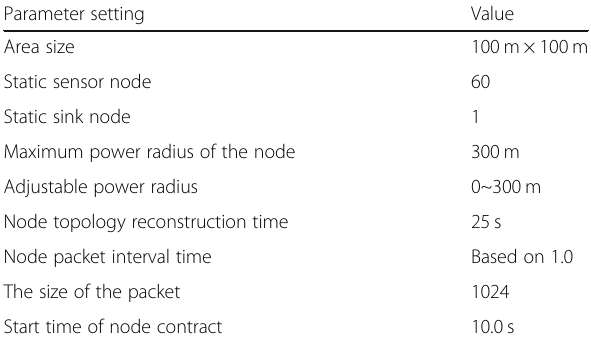
Table 1 Parameter setting of simulation experiment Parameter setting